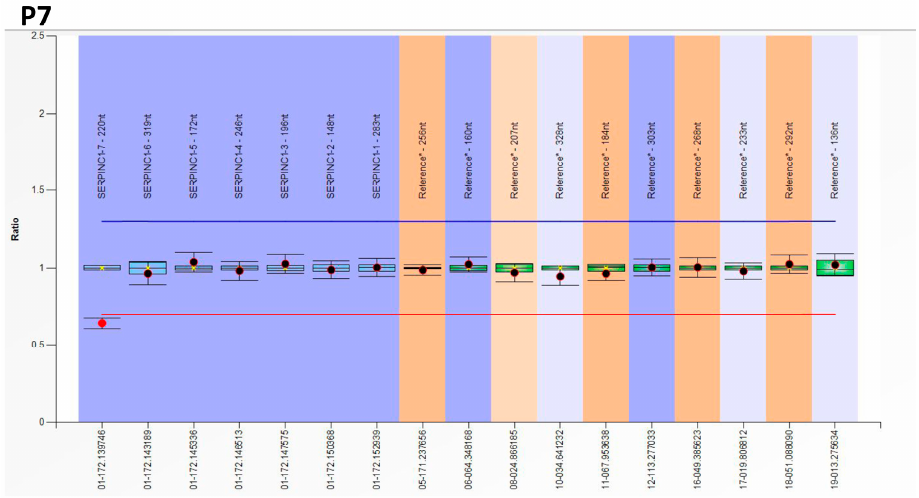
Figure 3. MLPA identification of a heterozygous deletion of exon 7 in patient P7 with antithrombin deficiency who carried a genetic defect previously identified by sequencing all 7 exons and flanking regions of SERPINC1 . Blue line shows the cut-off to consider gain of genetic material (duplication) and the red line loss